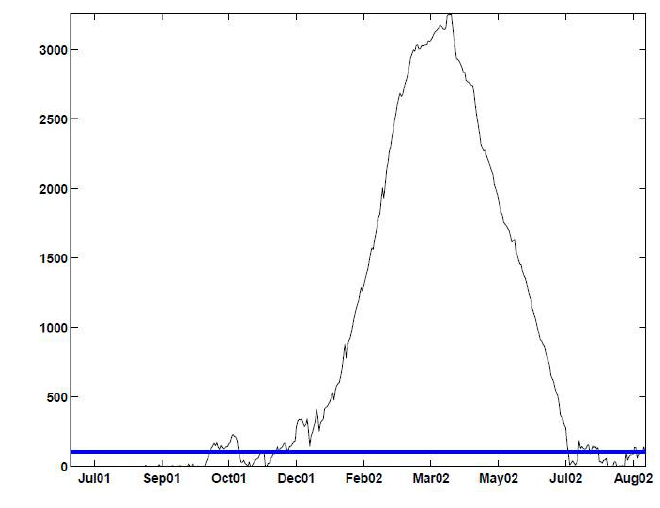
Figure 10. CuSum chart with k = 0 . 5 and h = 2 . 84 applied to the deseasonalized data. The chart signals alarms around five periods: October 13, 2001 to November 2, 2001; November 19–20, 2001, November 30, 2001 to July 4, 2002; July 13–27,2002, and August 23–31, 2002.